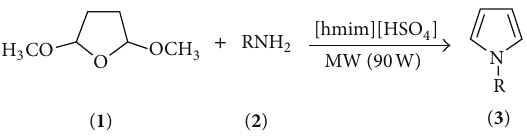
Scheme 1: The synthesis of N-substituted pyrroles catalyzed by [hmim][HSO 4